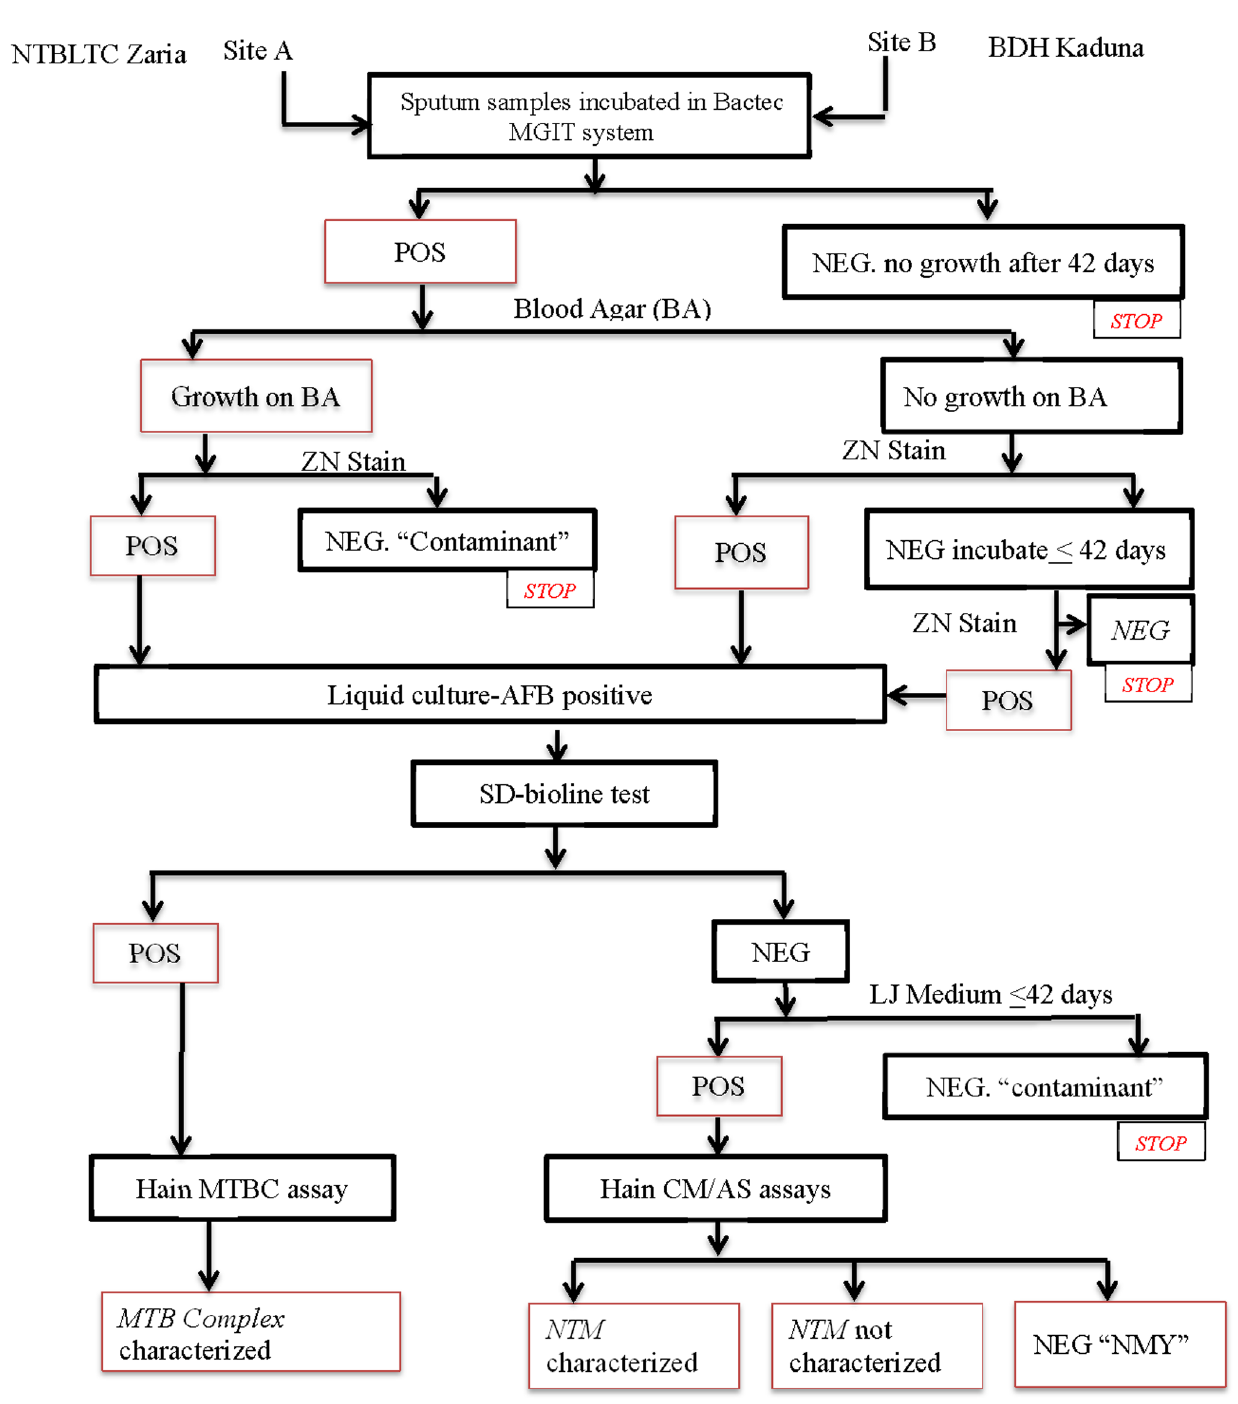
Figure 1. Mycobacterial Detection and Characterization. POS, positive; NEG, negative; ZN, Ziehl Neelsen; AFB, acid fast bacilli; NMY, not of the genus mycobacterium. doi:10.1371/journal.pone.0063170.g001 (NMY). Samples from 234 (14.6%) cases were contaminated and 903 (56%) samples of clinically symptomatic patients were without any detectable isolates by the study testing algorithm.